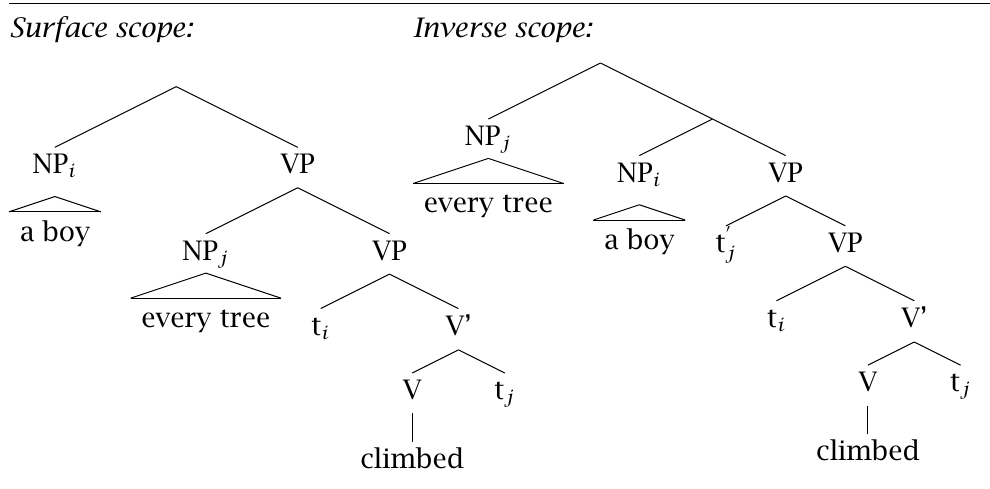
Figure 1 Two readings for A boy climbed every tree on a QR